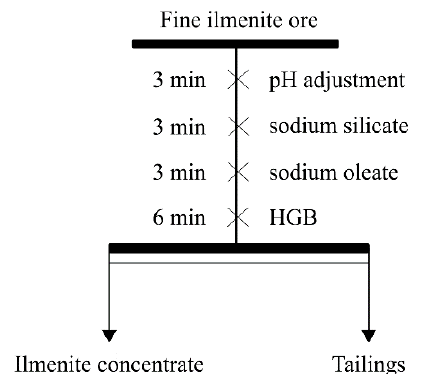
Figure 3. Flowsheet of ilmenite sample flotation.